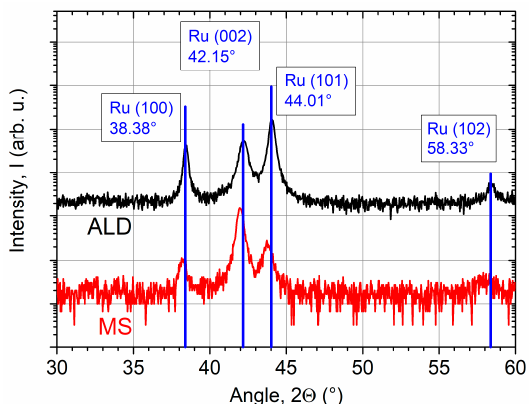
Figure 4. X-ray diffraction (XRD) pattern of ALD ( z = 57 nm) and magnetron sputtered (MS) ( z = 50 nm) Ru coatings on Si substrates with corresponding phase analysis. Diffraction peaks of the MS coating are slightly shifted to smaller angles indicating film stress.